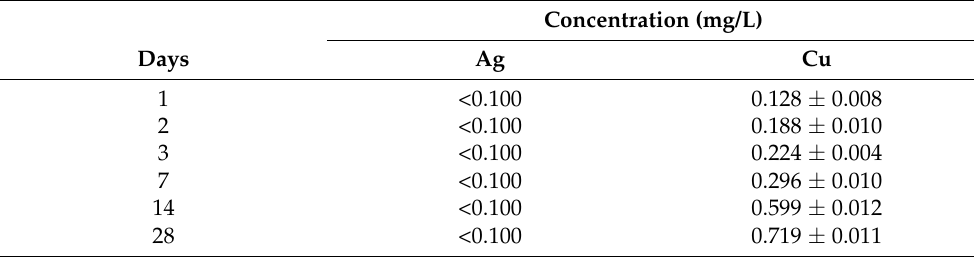
Table 4. Cumulative concentrations of Ag and Cu ions released from the nanoHAp/nanoAg/nanoCu coating after different times of exposure in simulated body fluids (SBF) at 39 ◦